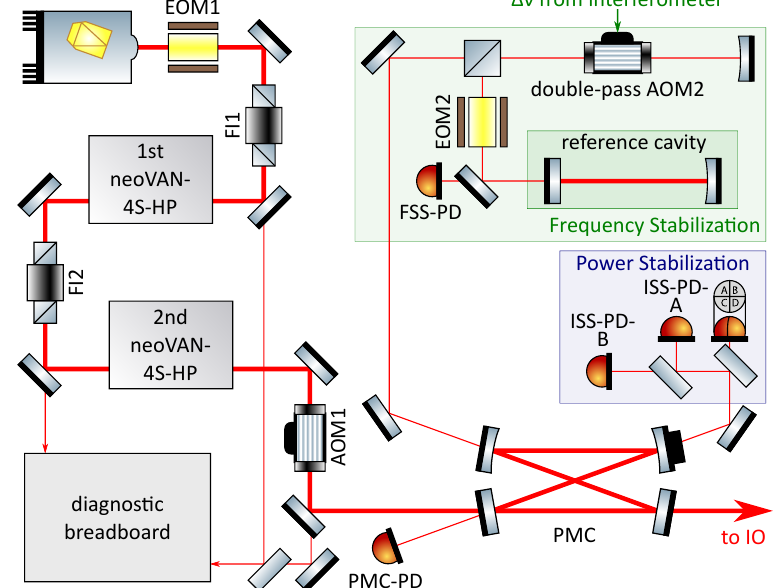
Figure 6. Schematic diagram of the aLIGO O4 pre-stabilized laser system. A non-planar ring oscillator laser (NPRO) seeds two sequential neoVAN-4S-HP amplifiers. The pre-stabilization concept is equivalent to the one used in